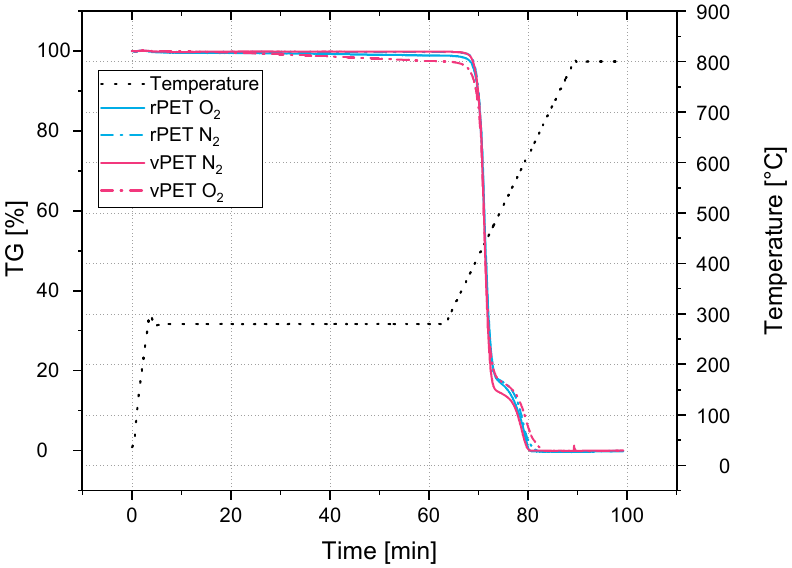
Figure 10. TGA of the isothermal degradation at 280 °C in different atmospheres. In order to analyze the pyrolytic black carbon content, the test was conducted entirely under a nitrogen atmosphere. The heating curve and the gravimetric changes are presented on Figure 11. After 38 min, the remaining mass, equal to the pyrolytic black carbon content, of the vPET was 14.9% and 15.0% for the recycled one. As for the onset temperature, where the material degradation started, the rPET started first at a temperature of 374 ◦ C and the virgin material at a temperature of 378 ◦ C. For the rest of the curve, both samples behaved almost equally.